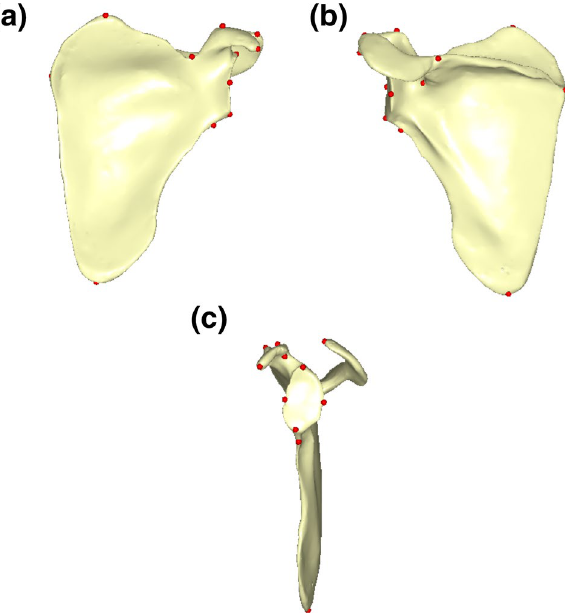
Figure 7. Landmarks configuration used in the study. Different views are observed, ( a ) internal view, ( b ) external view, ( c ) frontal